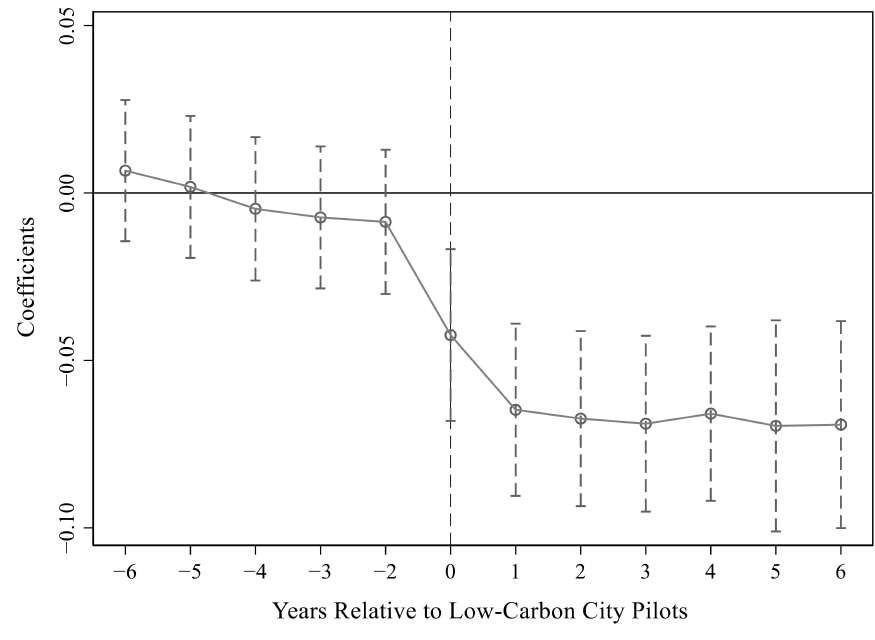
Figure 4. Parallel trend test in the first column of Table 12.